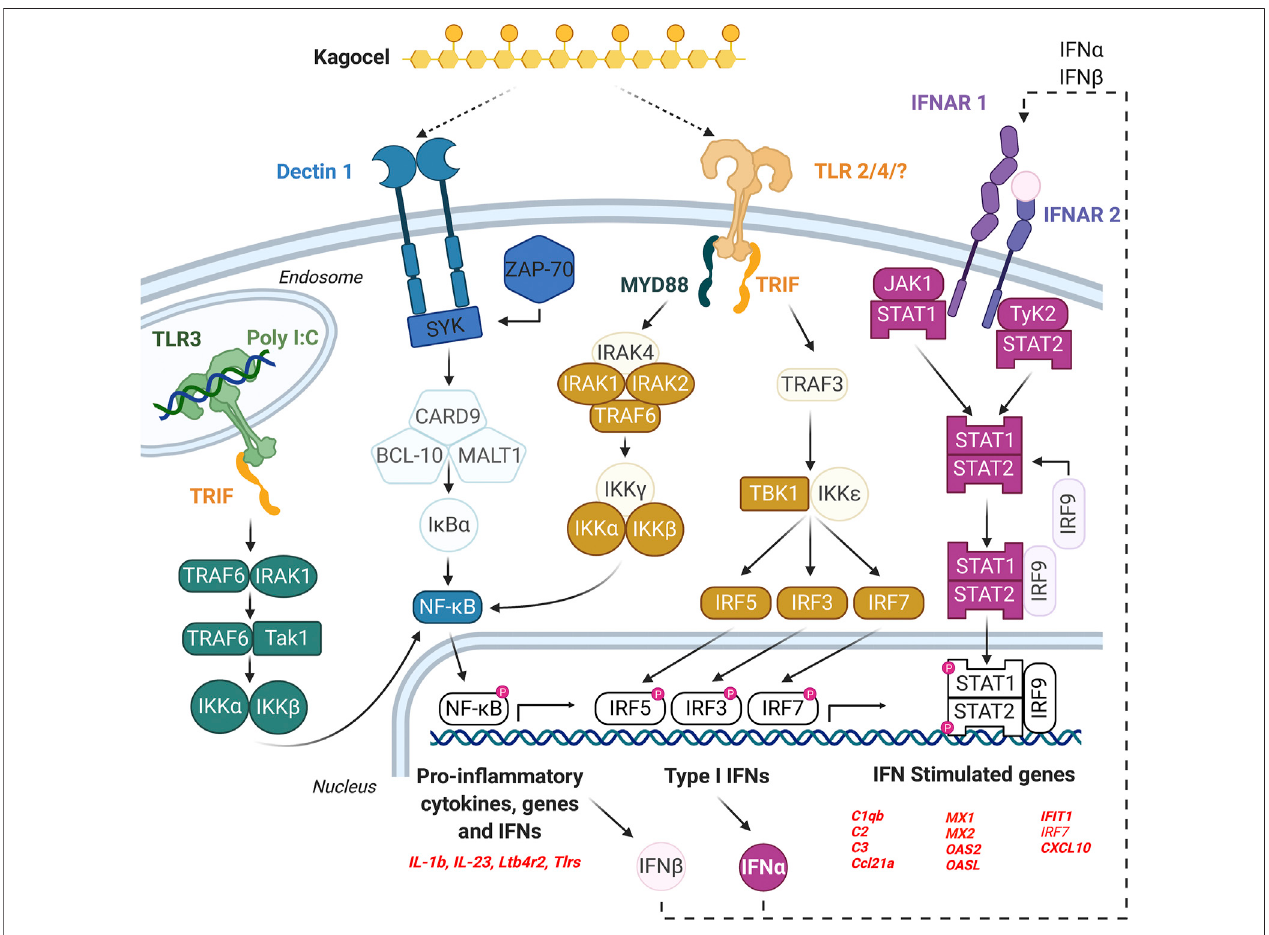
FIGURE4| Thepossiblemechanismofkagocelaction, assummarizedfromthestudy fi ndings.Theelementsofthenetworkhighlightedwithbold colorsareeither genes up-regulated in Peyer ’ s patch lymphocytes, or the transcription factors/master regulators identi fi ed using bioinformatics tools.